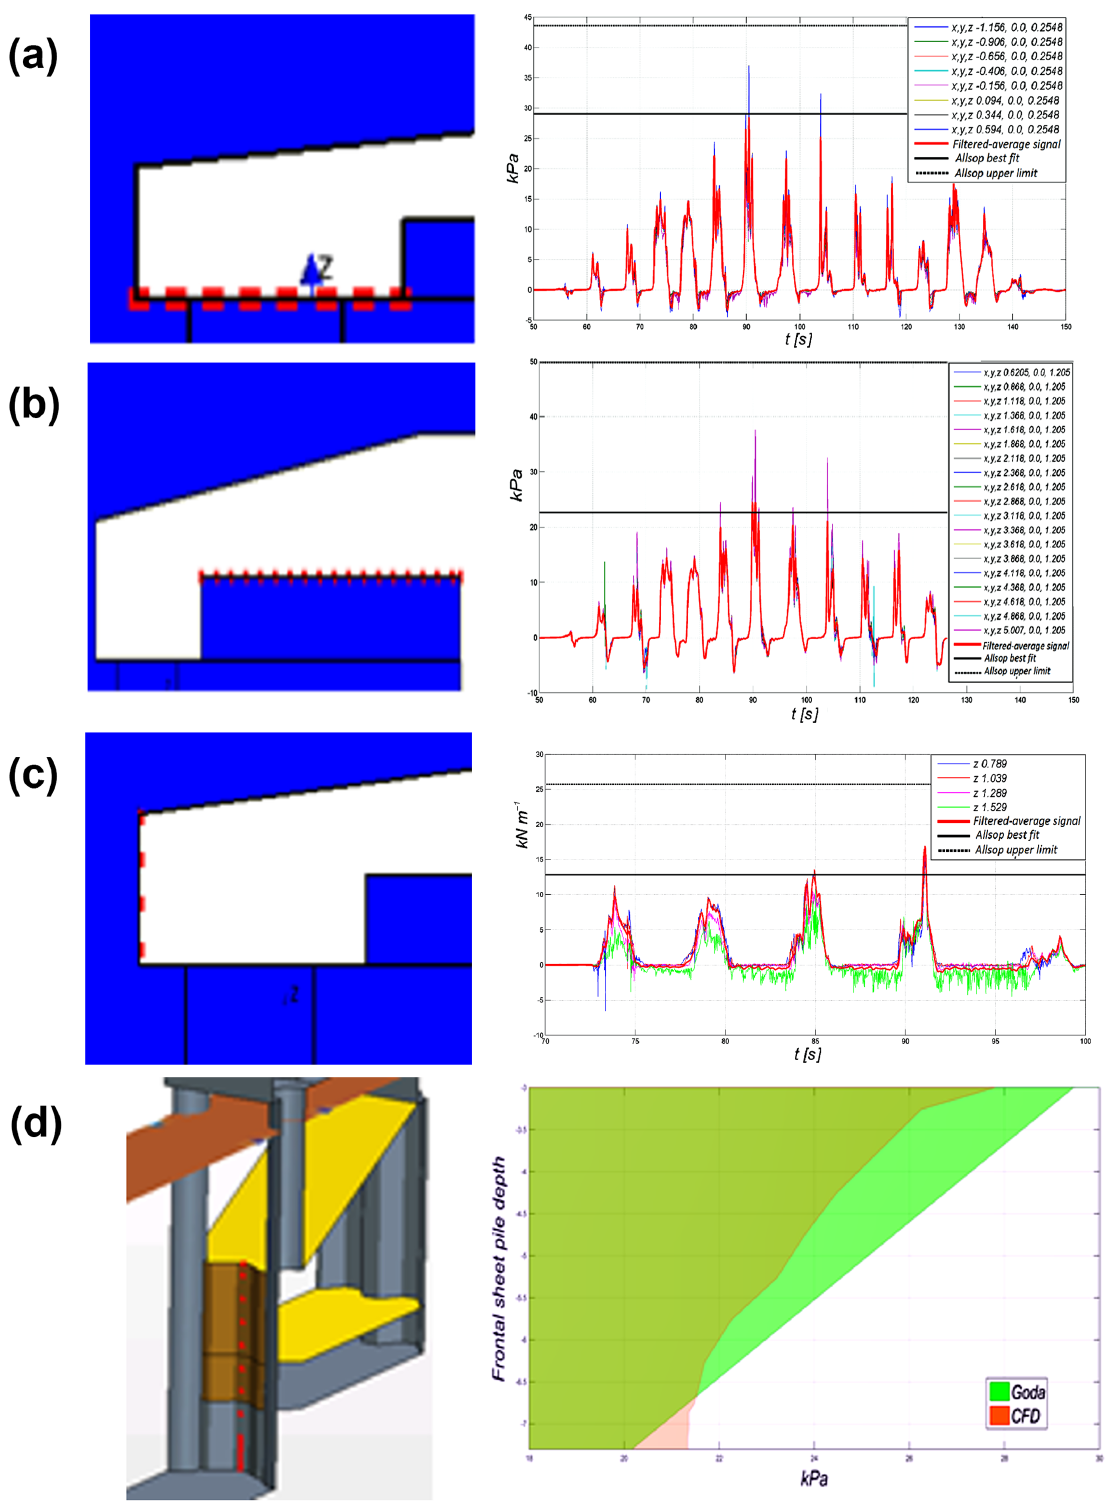
Figure 18. (a, b, c) Comparison between CFD results and empirical formulas proposed by McConnell et al. (2004) solid line refers to deterministic formula results while dotted line refers to probabilistic formula results. (d) Comparison between pressure distribution on the frontal sheet pile; orange refers to the CFD result and green refers to the well-known Goda’s